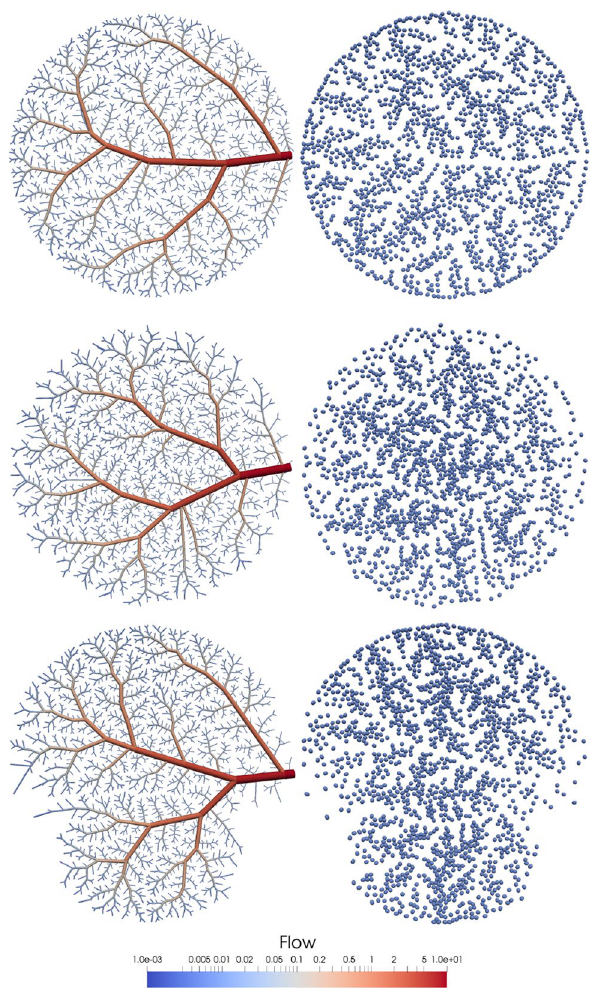
Figure 4. Flow delivery using different probability distribution functions for x d i generation: (first row) uniform distribution (standard CCO algorithm); (second row) Gaussian distribution x d i ∼ N (µ , σ 2 ) with µ = ( 0, 0 ) and σ = ( 0.25, 0.25 ) ; and (third row) Gaussian mixture of 2 distributions x d i ∼ 0.5 N (µ 1 , σ 2 1 ) + 0.5 N (µ 2 , σ 2 2 ) with µ 1 = ( 0, 0.5 ) , σ 1 = ( 0.25, 0.25 ) , µ 2 = ( 0, − 0.5 ) and σ 2 = ( 0.10, 0.10 ) . First column presents the